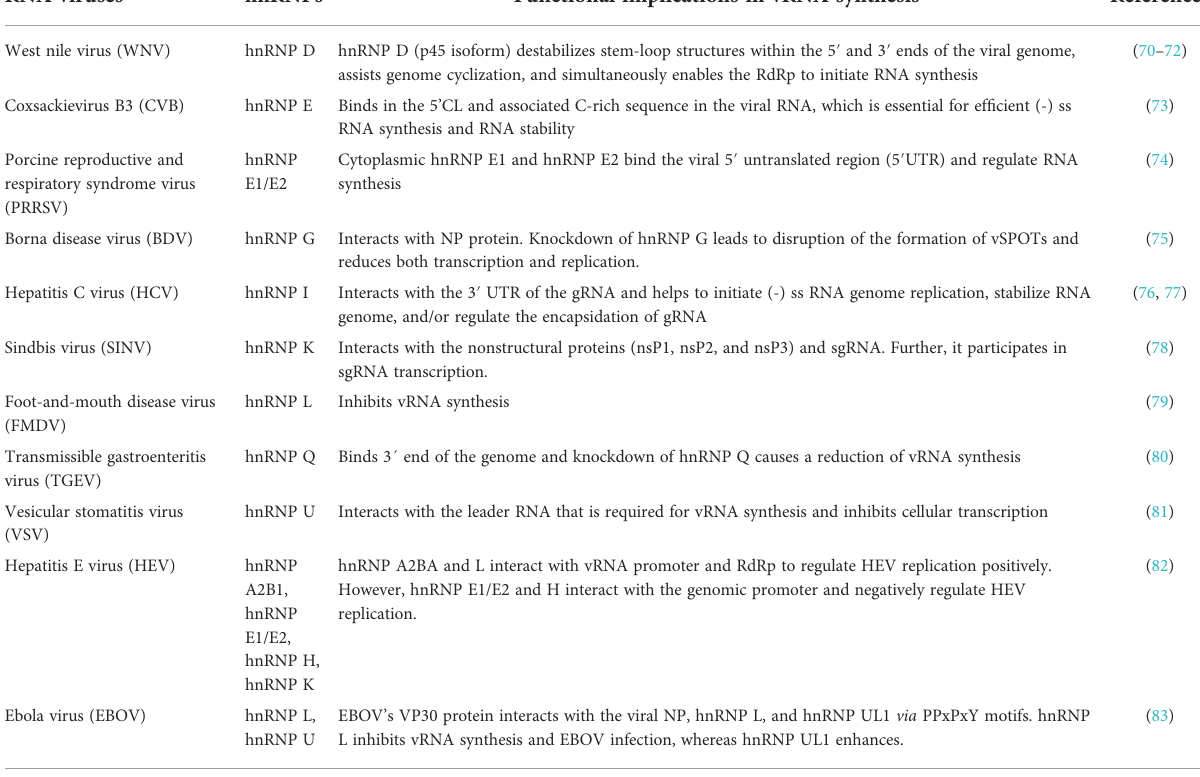
TABLE 2 hnRNPs involved in vRNA synthesis and transcription of different RNA viruses. RNA